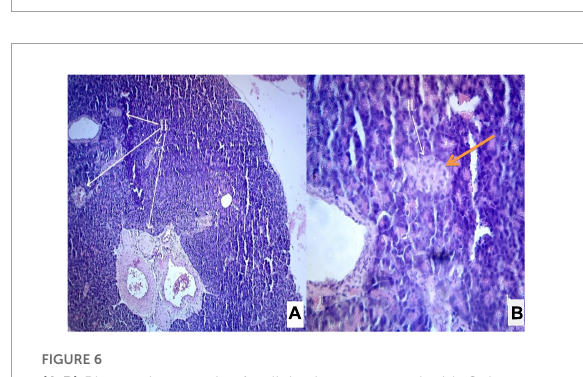
FIGURE6 (A,B) Photomicrograph of a diabetic rats treated with Solanum torvum fruits extract (200 mg/kg/b.wt.) section from pancreas showed maximum restoration of normal cellular population and regeneration of islets of Langerhans. The acinar cells are seen to be normal. (A) H & E 10X; (B) H & E 40X. IL, islets of Langerhans cells.